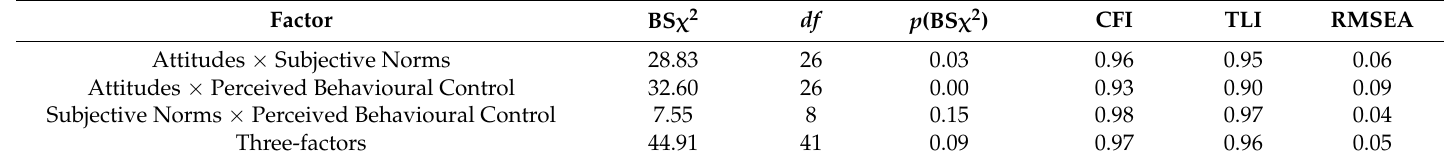
Table 2. Fit statistics and factor loadings of single-factor models of the indirect beliefs about green exercise (BAGE-ID). Factor and Items Factor Loadings BS χ 2 df p (BS χ 2 ) CFI TLI RMSEA Indirect Measure of Attitudes 10.84 9 0.13 0.98 0.97 0.06 When I do Green Exercise, I feel like I am getting fresh air 0.55 When I do Green Exercise, I feel better about myself afterwards 0.85 Green Exercise is good for my health 0.60 Green Exercise is good for my fitness 0.60 Doing Green Exercise helps me feel positive about myself 0.82 Green Exercise is enjoyable 0.60 Indirect Measure of Subjective Norms 6.23 5 0.05 0.94 0.89 0.08 0.31 My friends think I should do Green Exercise 0.64 My family think I should do Green Exercise 0.83 My peers do Green Exercise 0.48 0.15